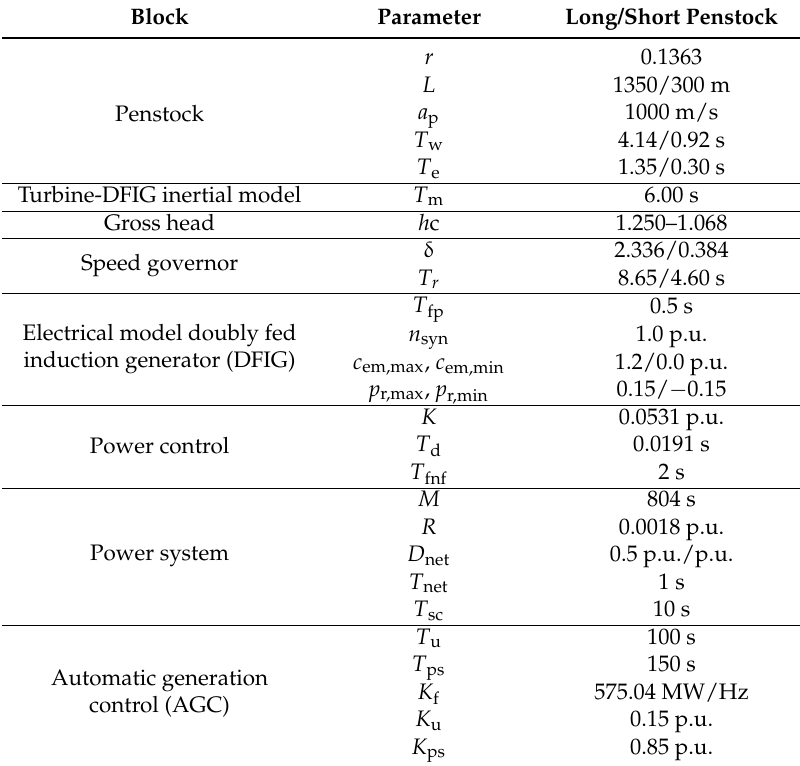
Table 2. Model parameter